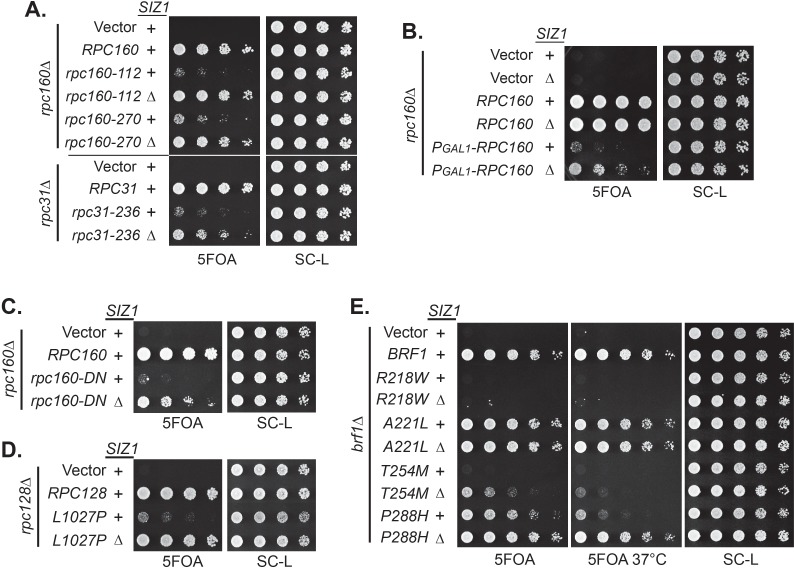
siz1Δ rescued a wide spectrum of Pol III mutations.(A) Plasmid shuffle experiments to test the growth phenotype of known rpc160 and rpc31 mutants in wild-type SIZ1 or siz1Δ background. The RPC160 or RPC31 alleles were on LEU2 vectors. The parental rpc160Δ and rpc31Δ strains contain a URA3 plasmid carrying wild-type RPC160 or RPC31, respectively. (B) Wild-type RPC160 was placed under control of the GAL1 promoter on a LEU2 vector then transformed into an rpc160 strain carrying a URA3 RPC160 plasmid, which was lost in the presence of 5FOA. The 5FOA plate contained glucose as the only carbon source, which strongly repressed RPC160 expression, making the cells grow extremely slowly. siz1Δ partially alleviated this growth defect. (C–E) Similar plasmid shuffle experiments showing the rescue effect of siz1Δ on disease causing mutations. rpc160-DN: D384N, N789I.